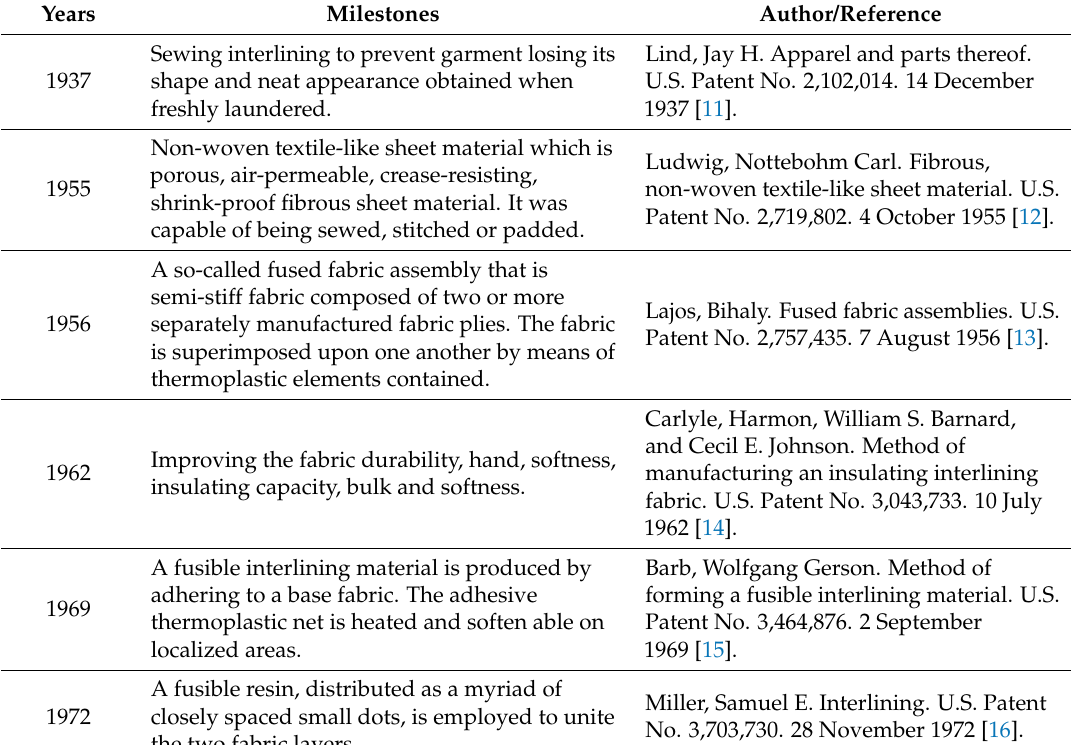
Table 1. Summary of interlinings’